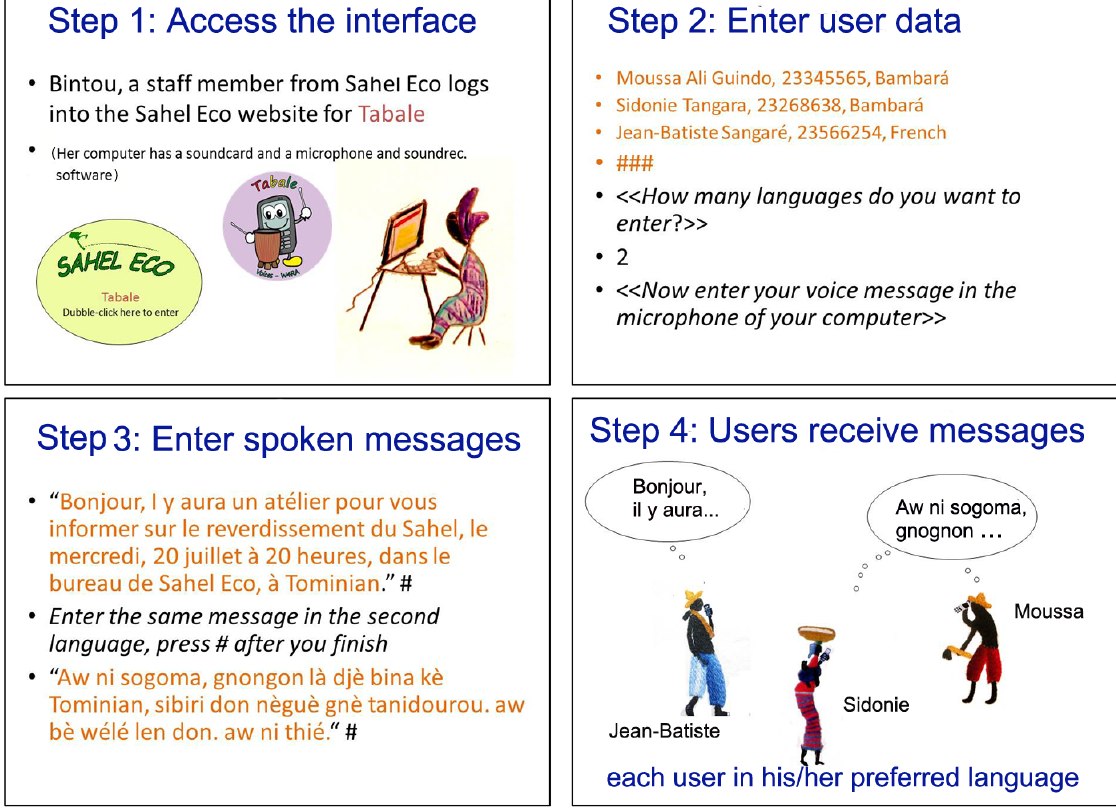
Figure 6. Storyboard showing a use case scenario for the envisaged Tabale